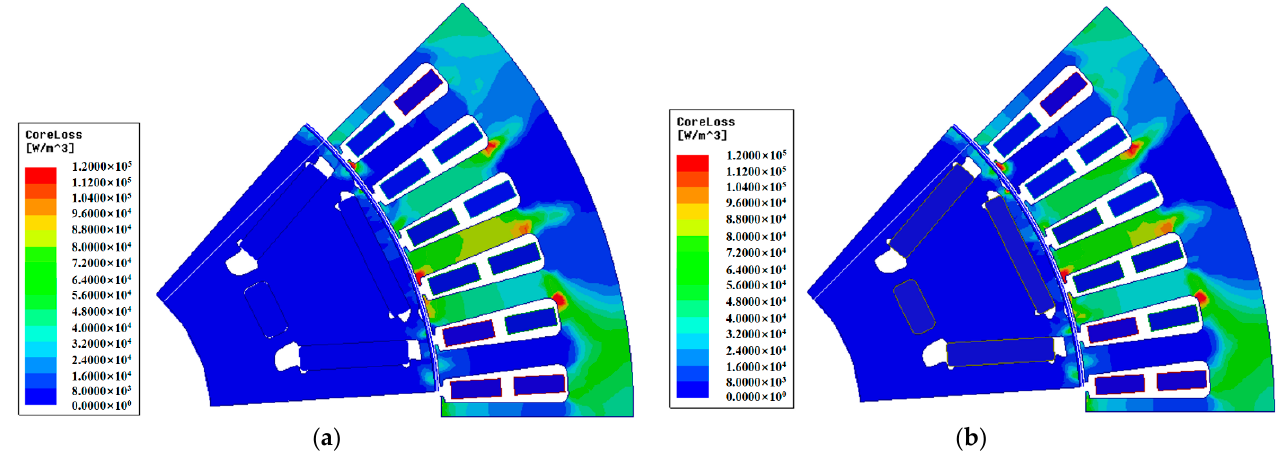
Figure 10. Iron loss distribution of two material motor under loaded condition. ( a ) 10JNEX900. ( b ) 20SW1200H.